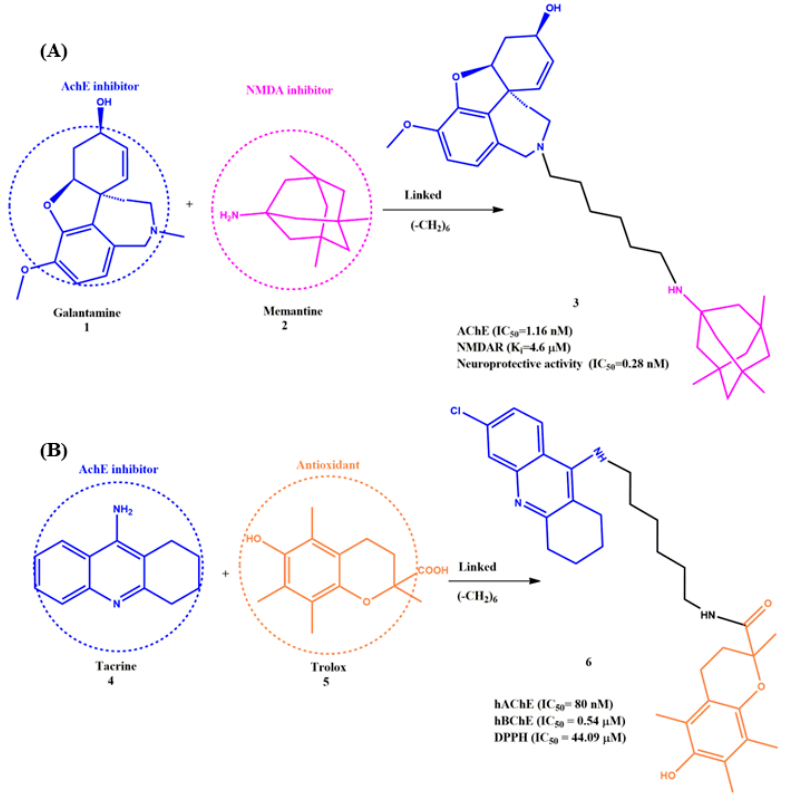
Figure 4. ( A ) and ( B ) Representative structure of linked pharmacophores. Eugenie et al. synthesized MTDLs based on the standard drug tacrine ( 4 ) in